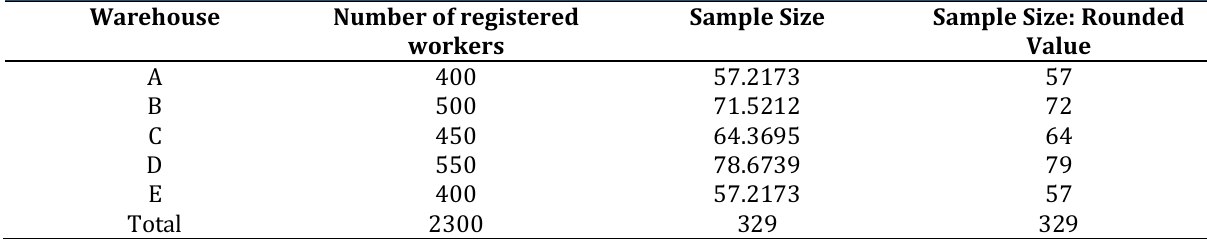
Source : Sample survey,